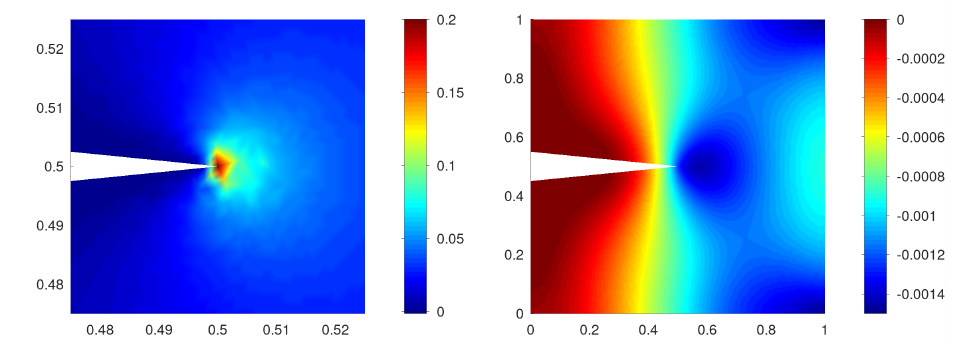
Figure 5. Snapshots of div u on the subdomain A ( left ) and temperature Θ in Ω ( right ) using δ = 0.1 at t =